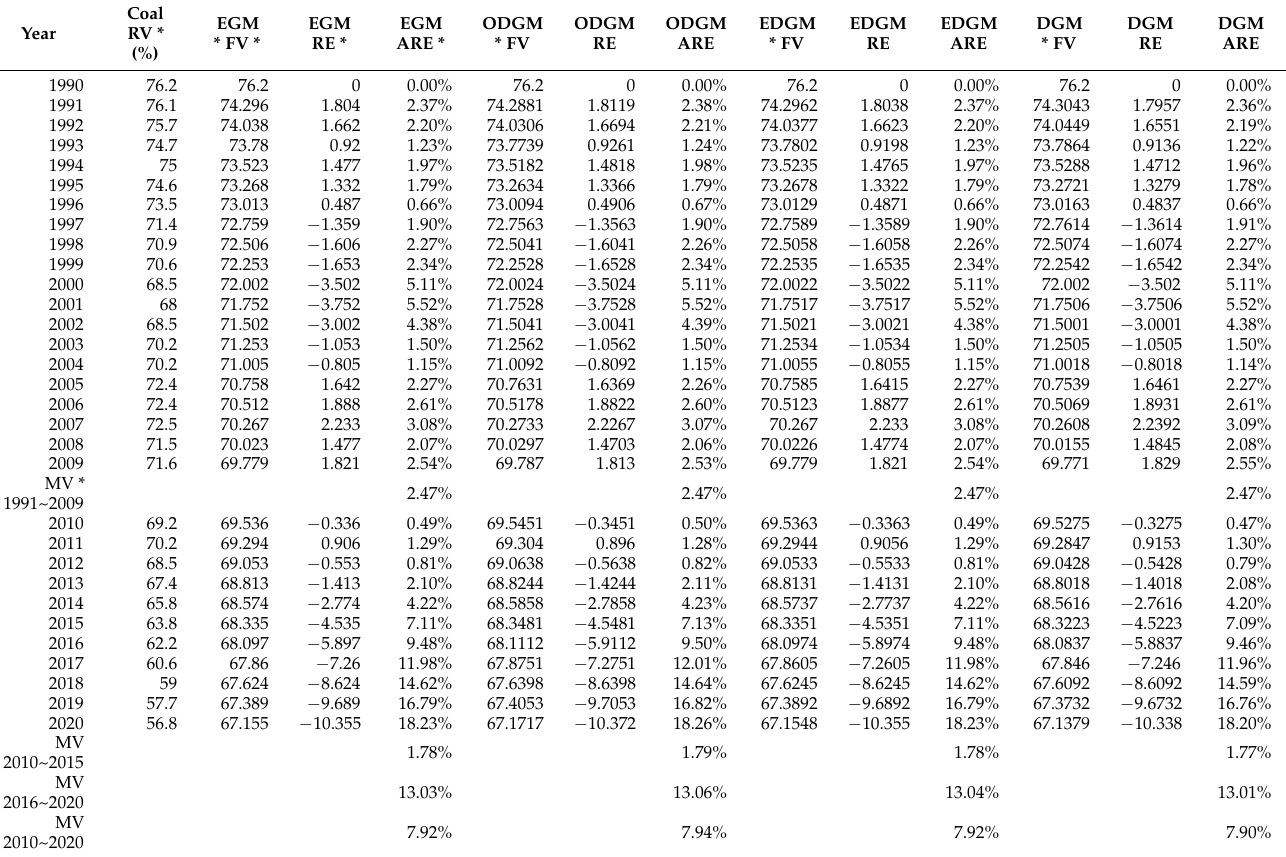
Table 1. Relative error report about coal consumption percentage based on